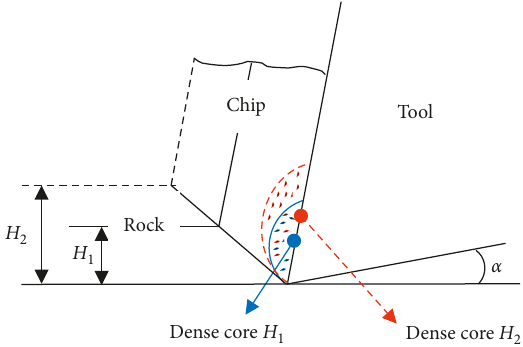
Figure 18: Schematic of the maximum stress point on the rack face.